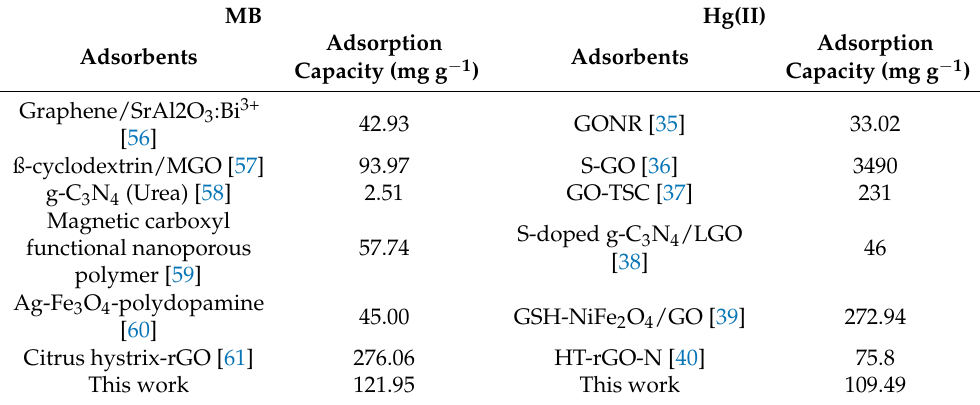
Table 6. Comparative adsorption capacity of several adsorbents for the removal of MB and